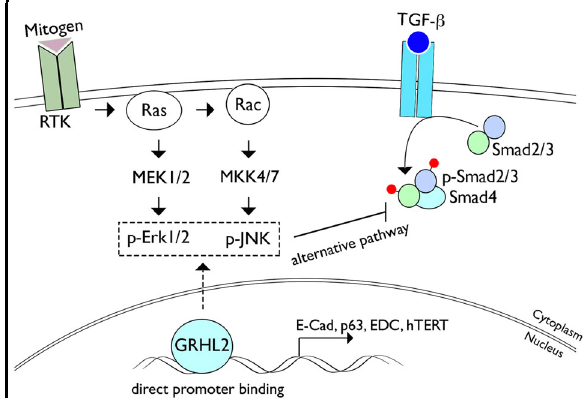
Fig. 8 Schematic representation for functional interaction between GRHL2 and TGF- β signaling through MAP kinase pathways. Mechanistic scheme is drawn to depict the functional interaction between GRHL2 and TGF- β signaling through Erk and JNK MAP kinase signaling. The current study identi fi ed an alternative pathway by which GRHL2 regulates TGF- β signaling through activation of the MAP kinase signaling pathways. This pathway is distinct from the transcriptional regulation of the target genes, e.g., E- cadherin, hTERT, p63, and miR-200 family genes, by direct GRHL2 binding at the promoter